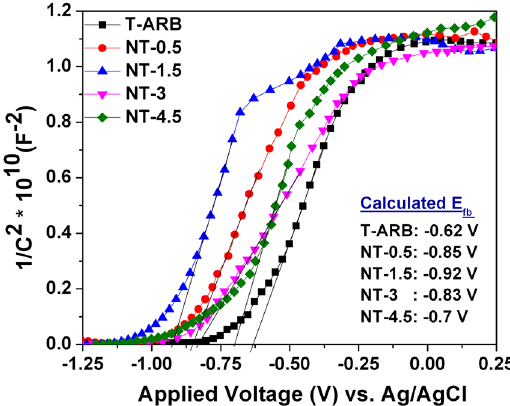
Figure 7. Mott Schottky plots of T-ARB and N-TiO 2